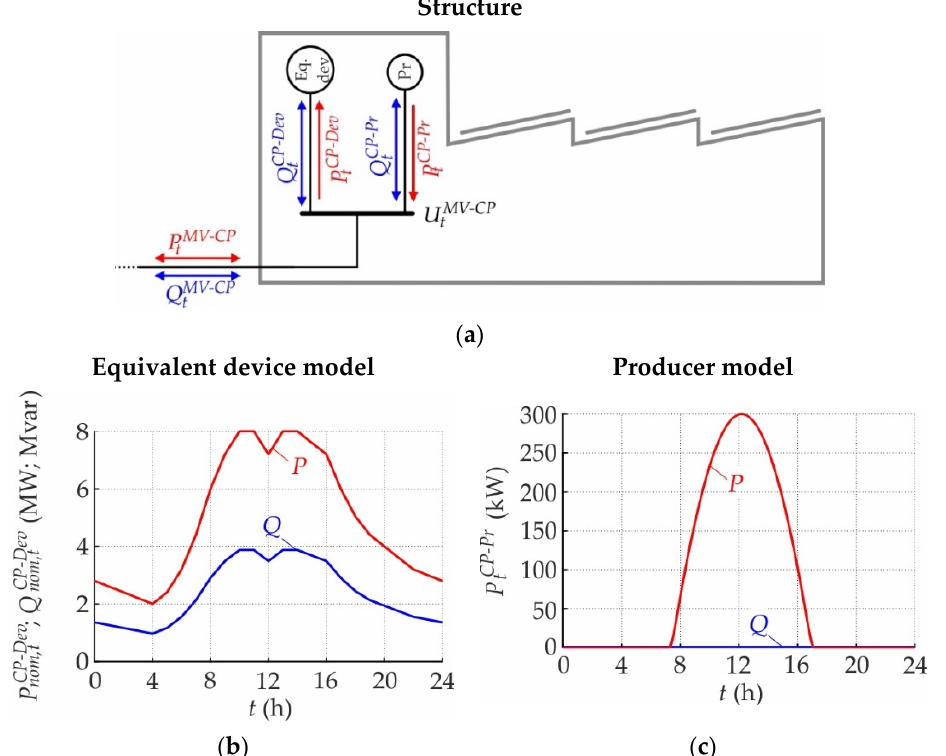
Figure A2. Industrial CP: ( a ) structure; ( b ) load profiles of the Dev.-model; ( c ) production profiles of the Pr.-model.